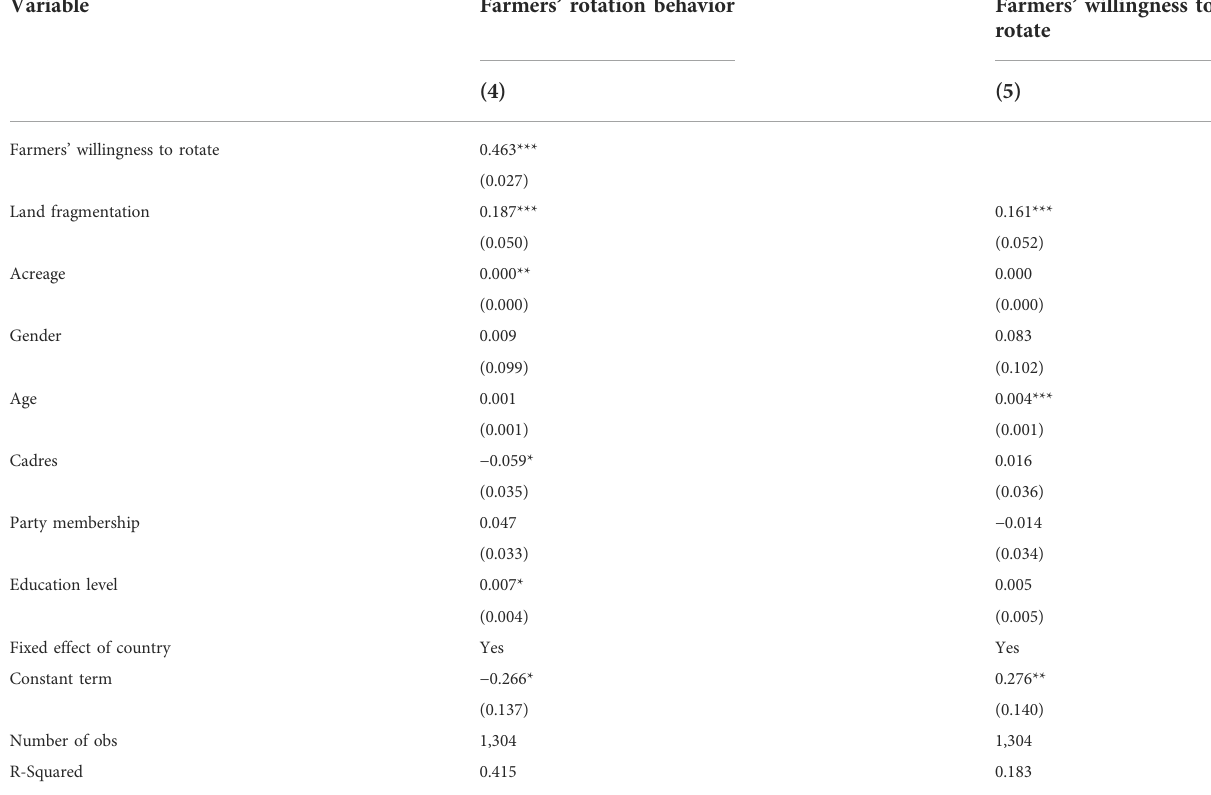
TABLE 4 Estimation results of mediating effect model of farmers ’ willingness to